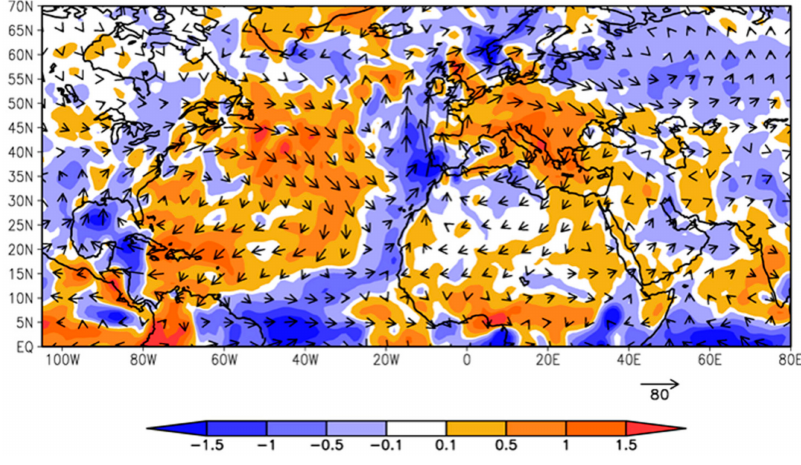
Figure 5. Anomalies of ERA-Interim vertically integrated moisture flux (vector, kg/m/s) and its respective divergence (shaded, mm/day) averaged for the 1989/1990